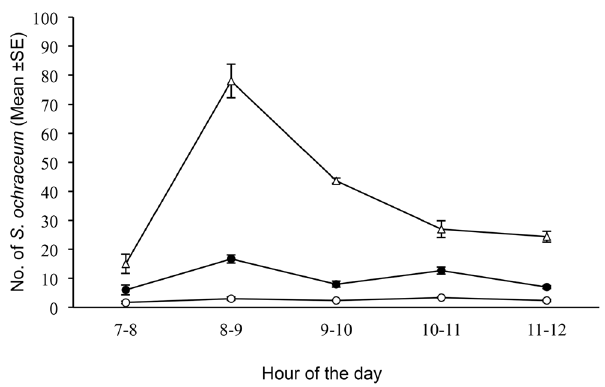
Figure 3. Performance of the original and tarpaulin based trap designs. Symbols present the mean and error bars of the standard error of collections taken over a three-day period. Open circles=collec- tions by the original acrylic sandwich design. Solid circles=collections by the modified tarpaulin based design. Open triangles=human landing collections.